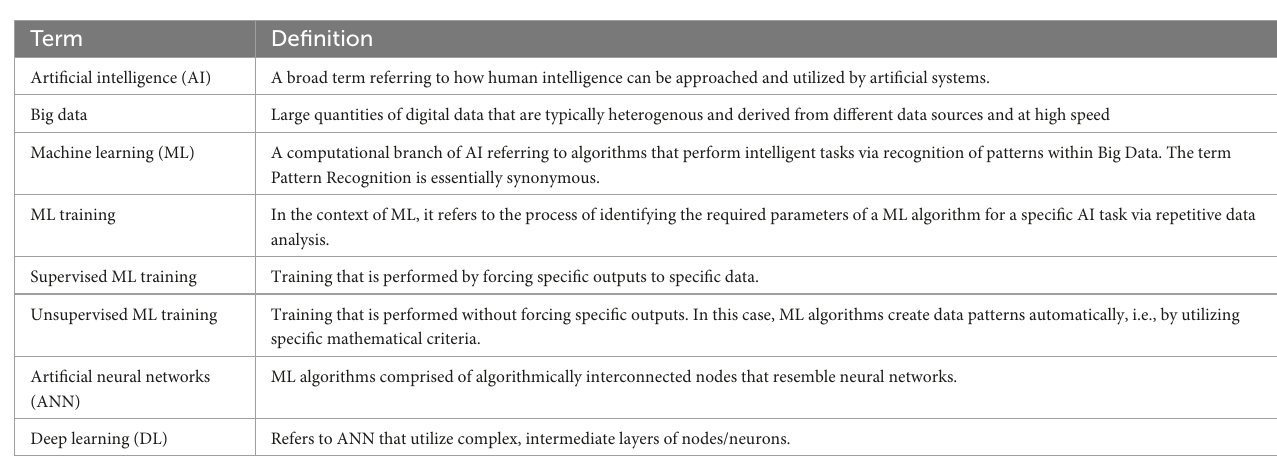
TABLE 1 Definitions of commonly used terms in artificial intelligence